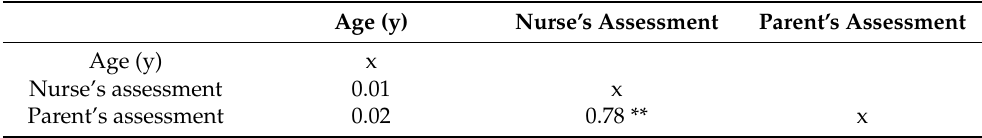
Table 7. Correlations between pain assessments by parents and nurses. Patients were <4 years of